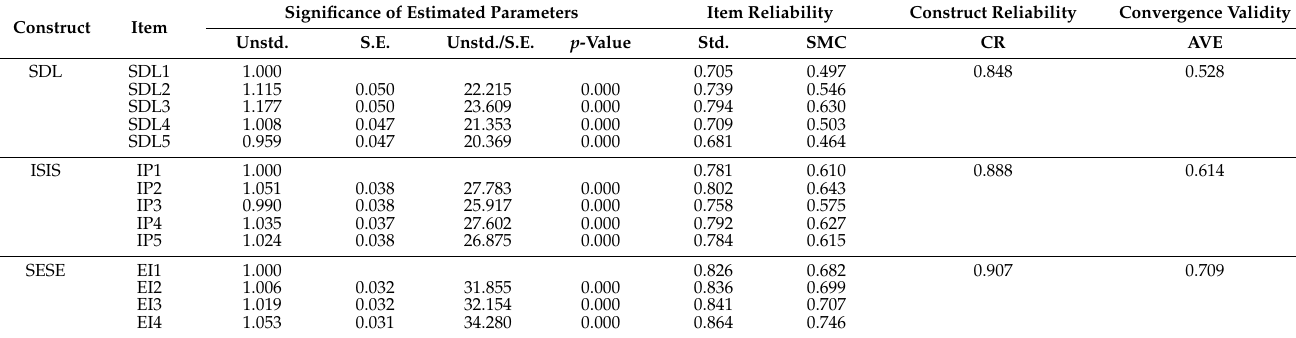
Table 4. Results for the measurement model.